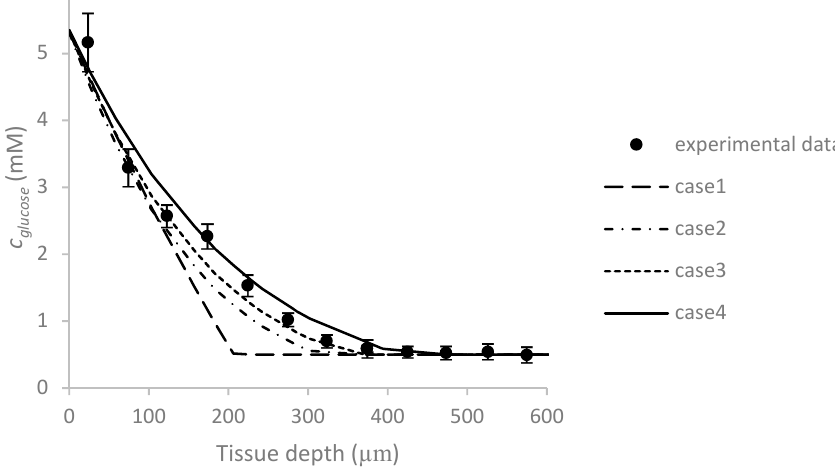
Figure 3. The comparison between the glucose concentration distribution inside tumor aggregate as a function of tissue depth obtained from present numerical results (case 1: V max = 0.01076 mM/s and K m = 0.04 mM, case 2: V max = 0.05773 mM/s and K m = 2.6 mM, case 3: V max = 0.05206 mM/s and K m = 3.1 mM and case 4: V max = 0.03596 mM/s and K m = 2.9 mM) and experimental data conducted by Panteli and Forbes [31]. For both experiment and simulation, the flow rate and initial glucose concentration are Q = 3 µ L/min and c 0, glucose = 5.5 mM, respectively.